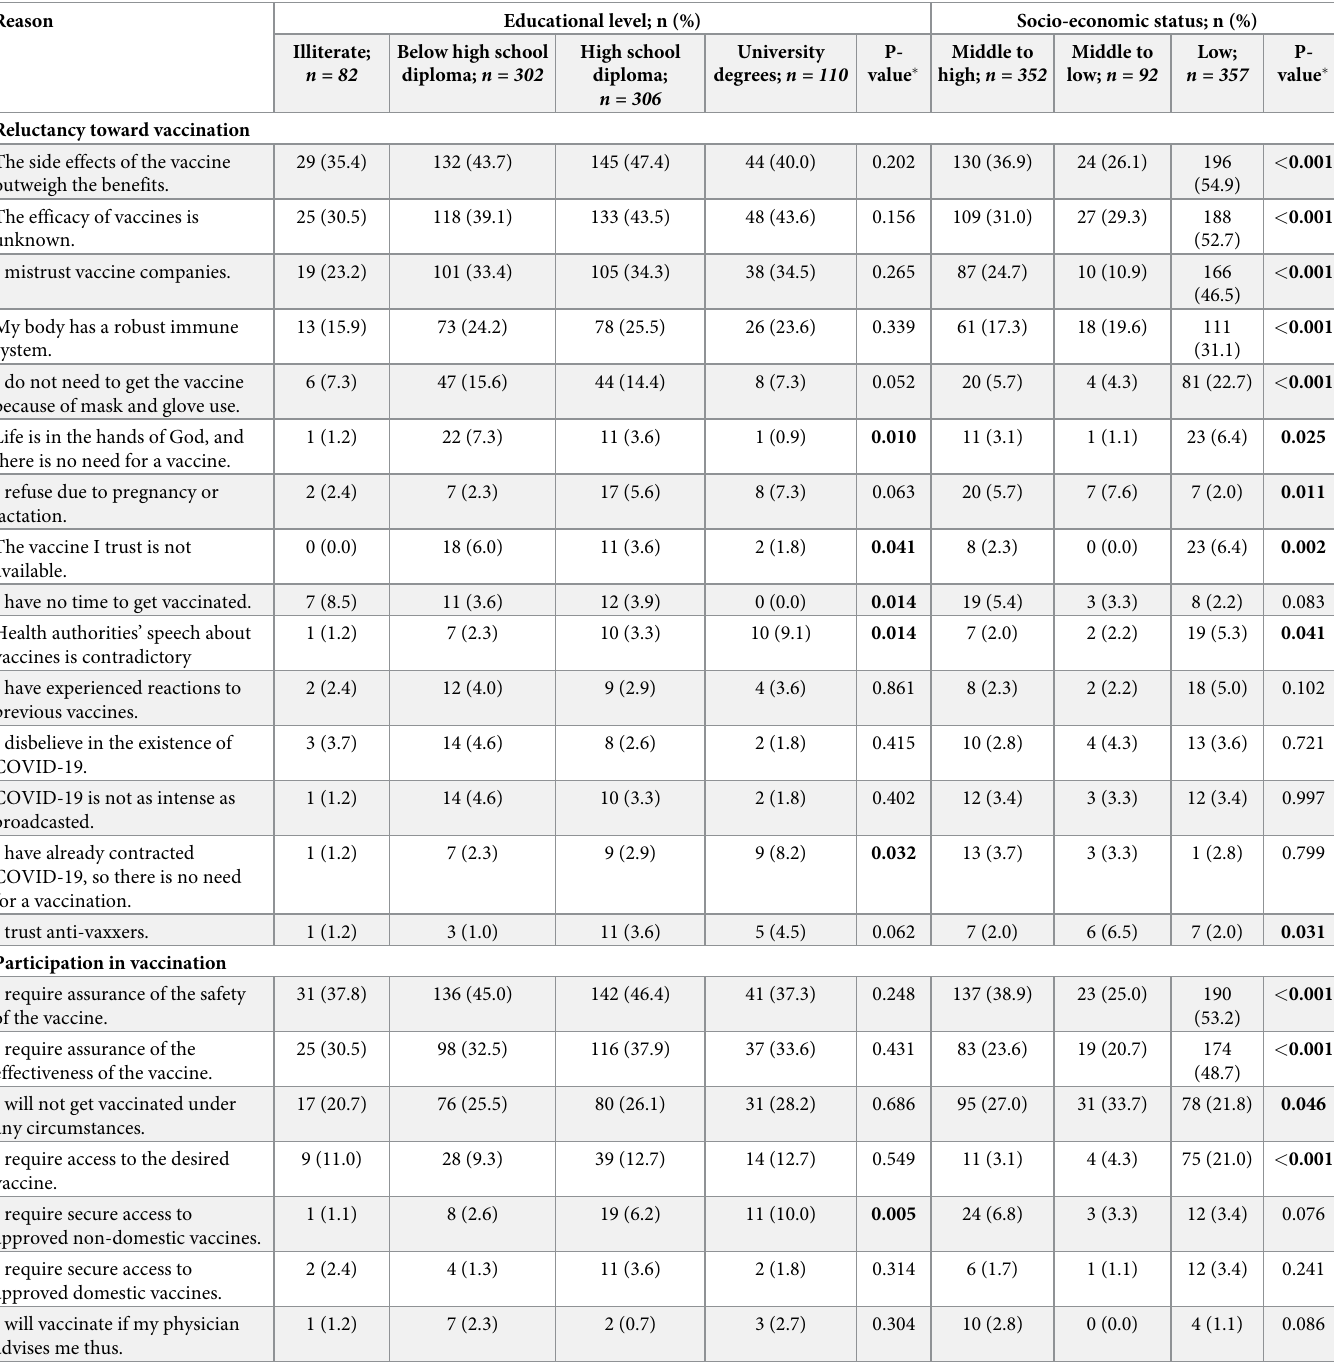
Table 5. Association of educational level and social-economic status with reluctance towards coronavirus disease vaccination and motivations for participation in vaccination among the general population of Shiraz. Reason Educational level; n (%) Socio-economic status; n (%)